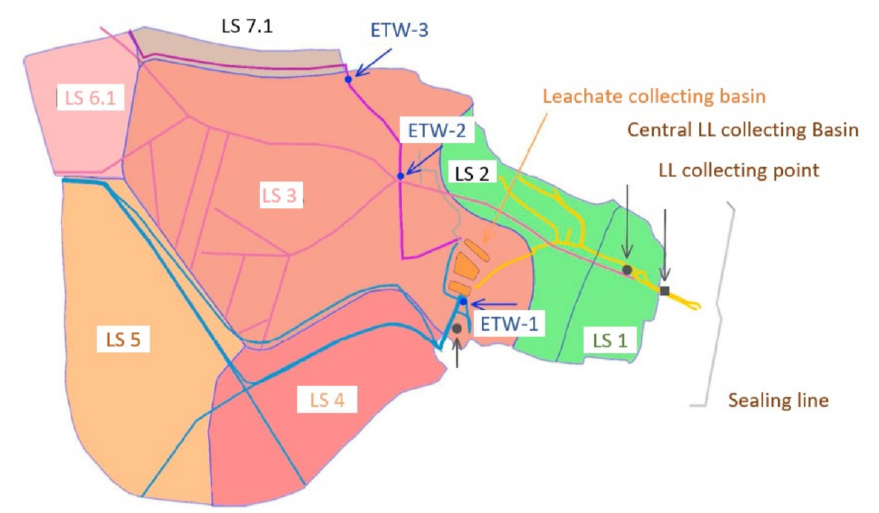
Figure 1. Landfill sections of Leppe landfill. LS: landfill section; ETW: extraction well [18].